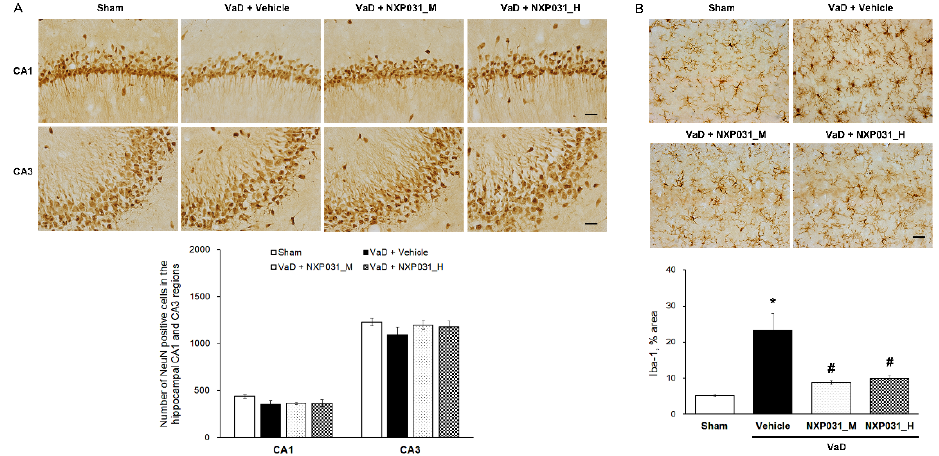
Figure 2. Effect of NXP031 on CCH-induced microglial activation in the hippocampus. ( A ) Repre- sentative photographs of immunostaining of NeuN-positive cells in the hippocampal CA1 and CA3 regions after CCH. ( B ) Representative photographs of immunostaining of Iba-1 in the hippocampal CA1 region after CCH. The data are presented as the mean ± S.E.M. * p < 0.05, compared with the sham group. # p < 0.05, compared with the VaD group. Scale bar: 50 µ